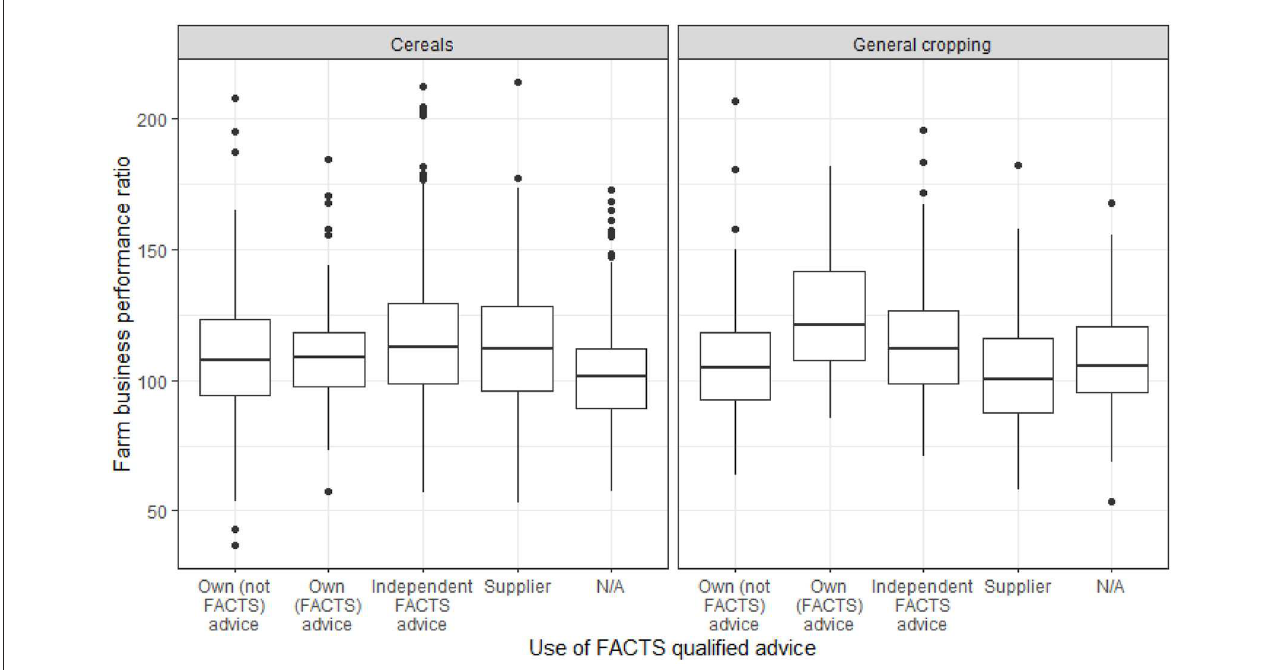
FIGURE4 Box plots of farm business performance against the use of FACTS qualified advice, for cereals and General Cropping farms. Scores of N/A are assigned for pre 2016 when FACTS data were not